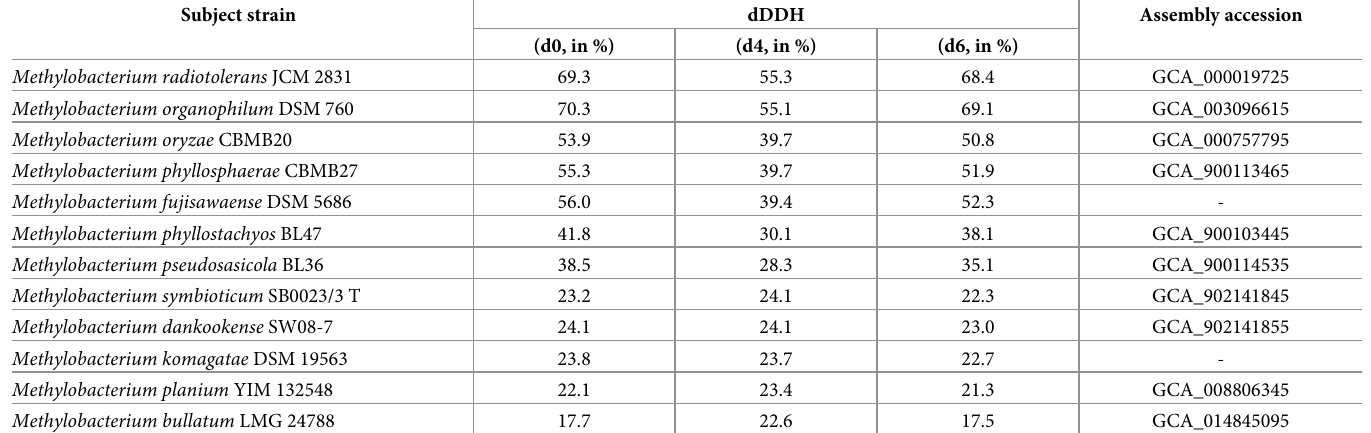
Table 3. Pairwise comparisons of NMS14P using dDDH against type strain